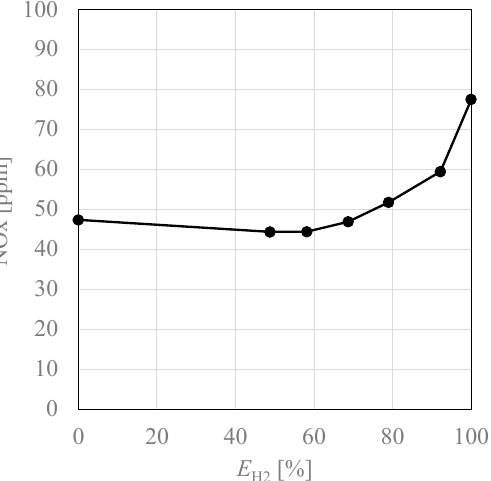
Figure 10. NOx in a small test furnace at 1273 K and P = +15 Pa. Input = 11 kW, λ = 1.2.